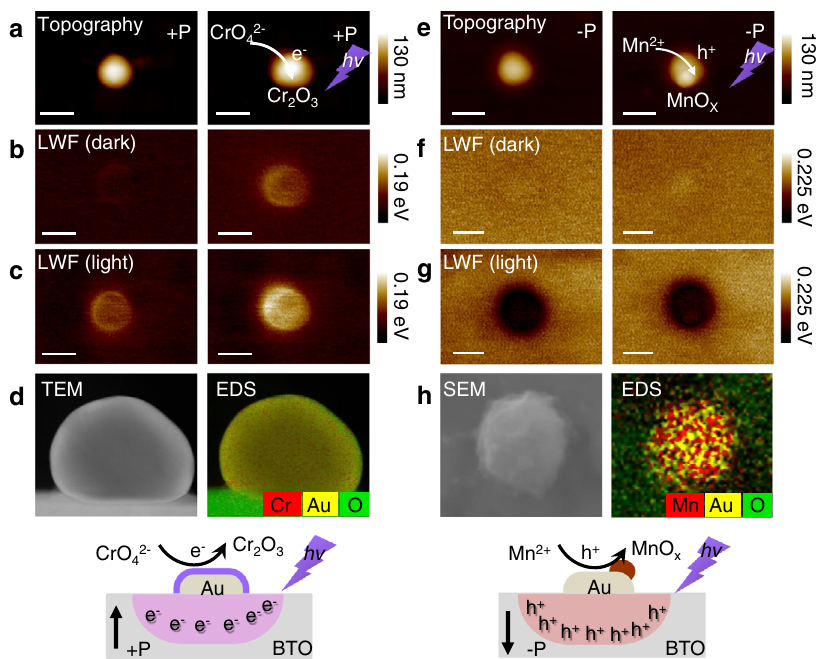
Fig. 3 In situ photodeposition experiments. a – d Photoreduction on Au at + P BTO. a AFM topography of Au/BTO at + P before (left) and after (right) photodeposition. b LWF in the dark before (left) and after (right) photodeposition. The darker region indicates a higher LWF. c LWF in the light before (left) and after (right) photodeposition. Scale bar, 200 nm. d TEM image (left), DES image (right), and schematic illustrations of photoreduced Cr 2 O 3 on Au at + P (bottom). e – h Photooxidation on Au at − P BTO. e AFM topography of Au/BTO at − P before (left) and after (right) photodeposition. f LWF in the dark before (left) and after (right) photodeposition. g LWF in the light before (left) and after (right) photodeposition. Scale bar, 200 nm. h SEM image (left), DES image (right), and schematic illustrations of photooxidized MnO x on Au at − P